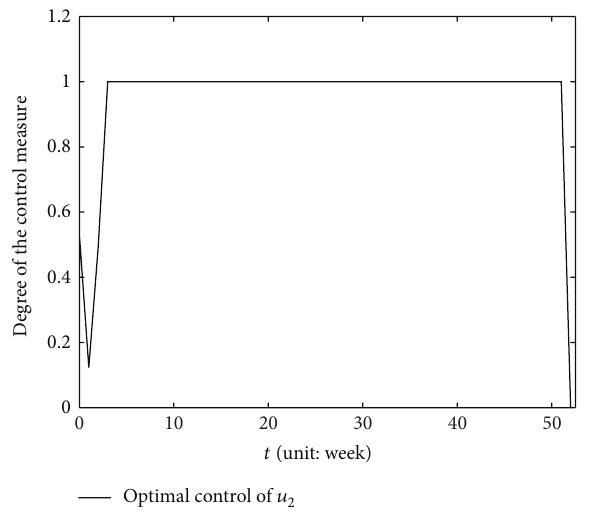
Figure 16: Figures of the optimal control 𝑢 2 when we choose the weight in objective function are 𝑐 1 = 10 4 , 𝑐 2 = 10 2